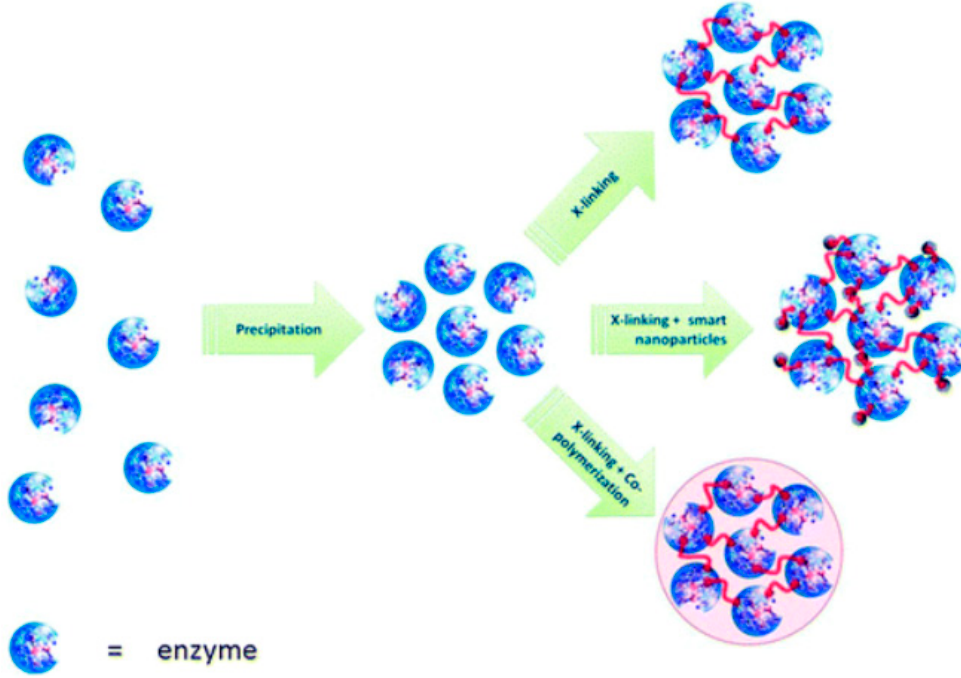
Figure 9. Formation of cross-linked enzyme aggregates (CLEAs) [145]